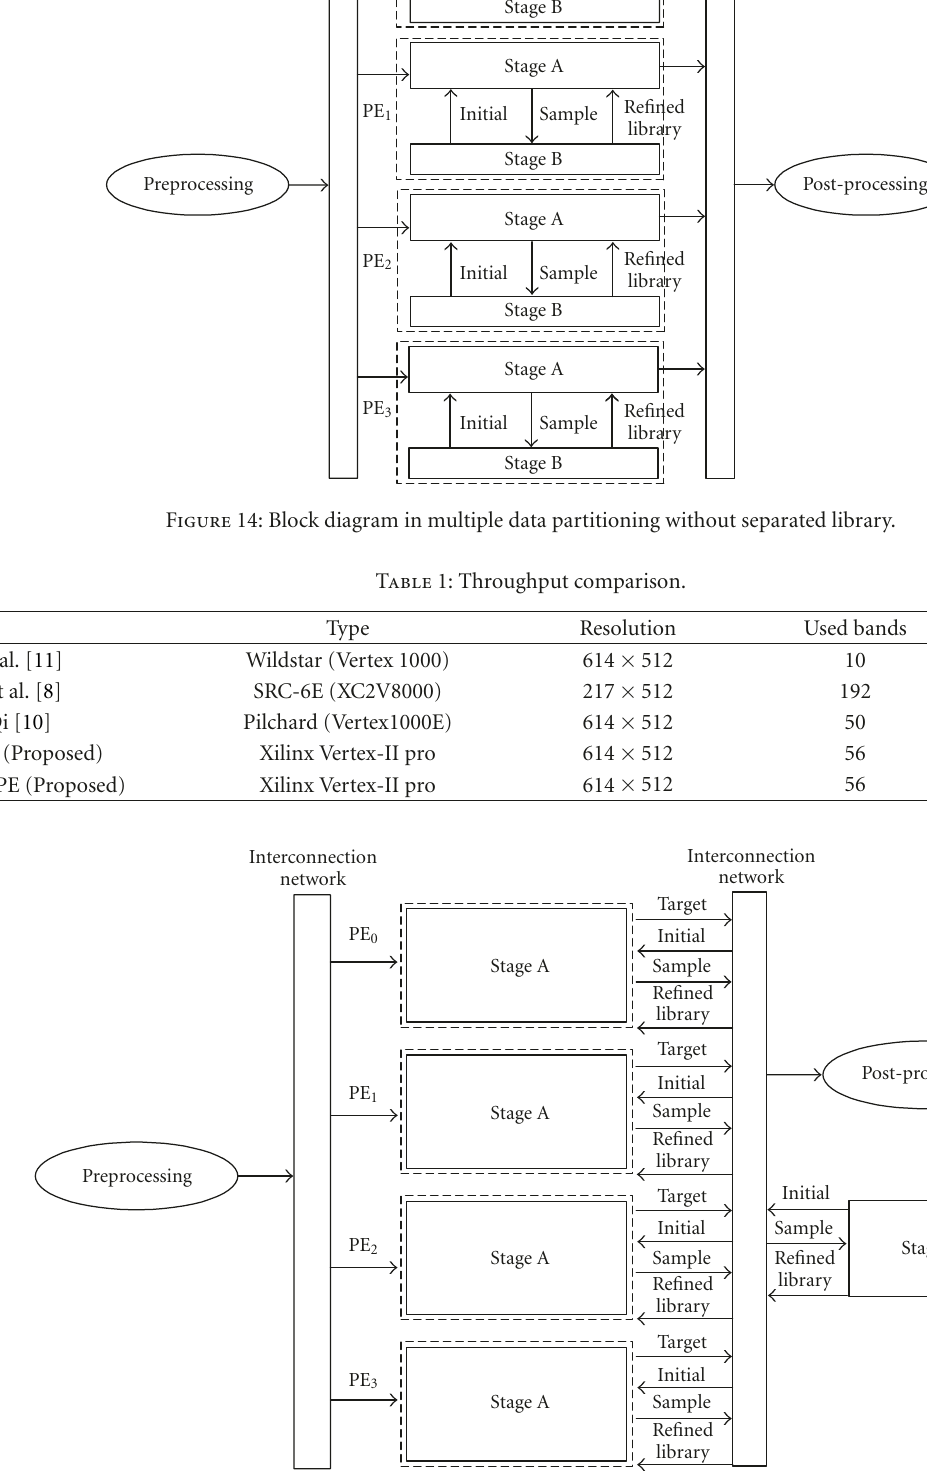
Figure 15: Block diagram in multiple-data partitioning with shared